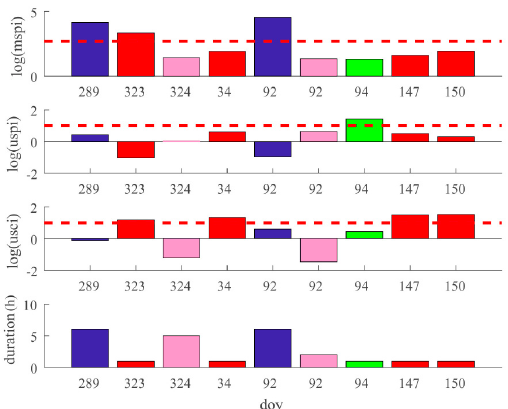
Figure 4. Unhealthy state statistics of C07. The subfigures correspond to mspi, uspi, usci, and duration of the unhealthy states, respectively. Blue bars represent Type 1 unhealthy states. Green bars represent Type 2 unhealthy states. Red bars represent Type 3 unhealthy states. Pink bars represent Type 5 unhealthy